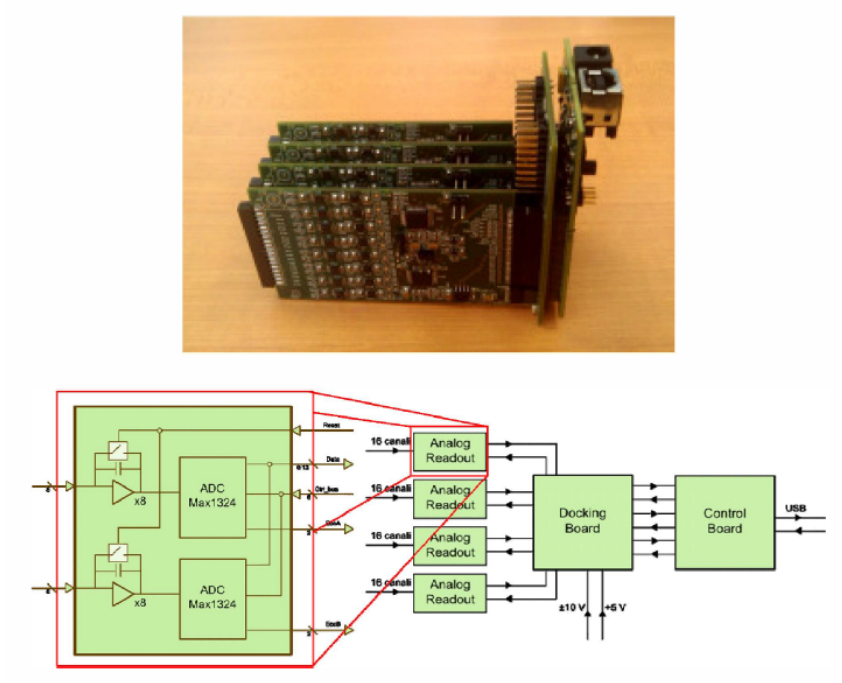
Figure 2. On the top part, a picture of the whole electronic system: four analog readout boards, a docking board and the FPGA based control board. On the bottom part, a block diagram representing the board configuration [21].